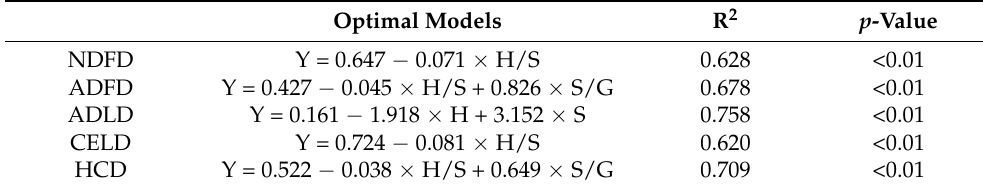
Table 7. Multiple regression models among lignin composition parameters and fiber fractions degradation (stepwise regression).